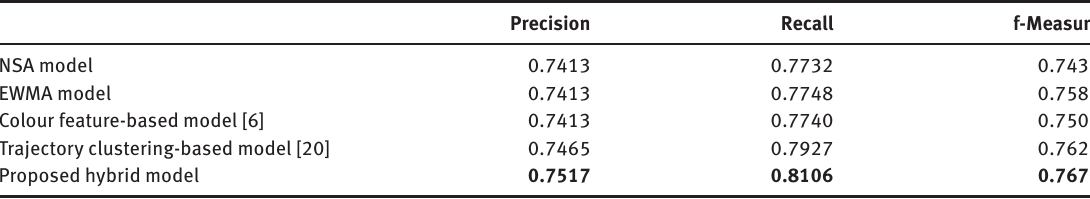
Table 1: Average Performance of the